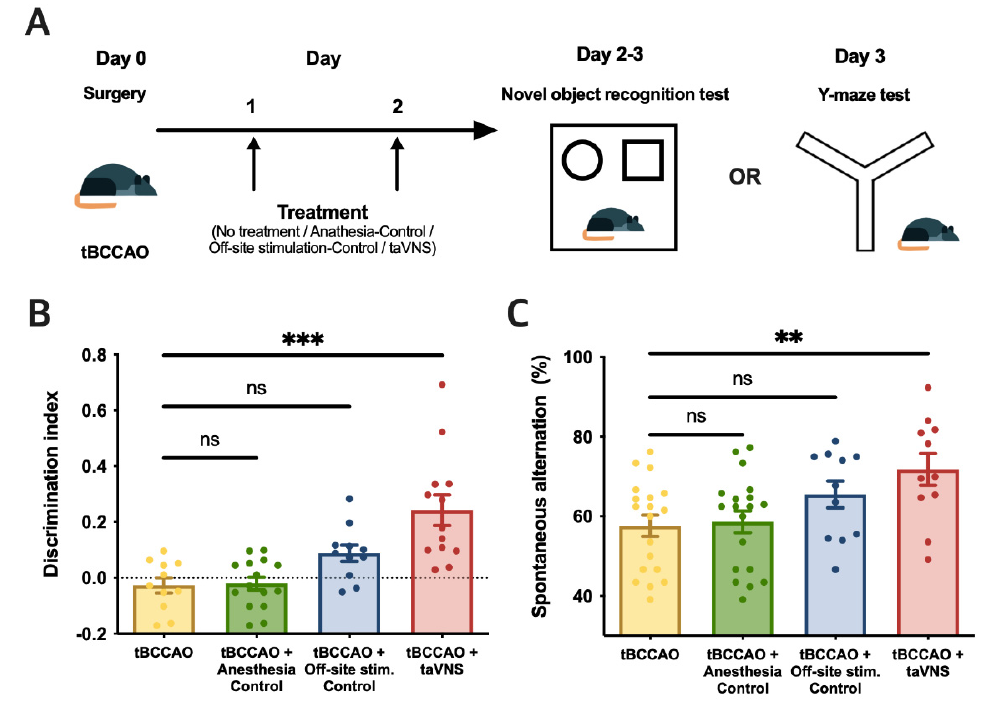
Figure 5. Impaired cognitive function was also significantly restored after two taVNS sessions. ( A ) Experimental scheme. ( B ) In the NOR test, the discrimination index score of the taVNS treatment group (red, n = 13) significantly increased in comparison to the tBCCAO group (no treatment, yellow, n = 11; p < 0.001). The discrimination index scores of both the anesthesia control group (green, n = 15) and off-site stimulation control group (blue, n = 11) were not different from the tBCCAO group. ( C ) In the Y-maze test, the spontaneous alternation rate of the taVNS treatment group (red, n = 11) was significantly higher than that of the tBCCAO group (no treatment, yellow, n = 19; p = 0.008). The spontaneous alternation rates of both the anesthesia control group (green, n = 19) and off-site stimulation control group (blue, n = 11) were not different from the tBCCAO group. The error bars indicate the SEM. One-way ANOVA with post hoc Dunnett test was used. ** p < 0.01; *** p < 0.001; ns, not significant.